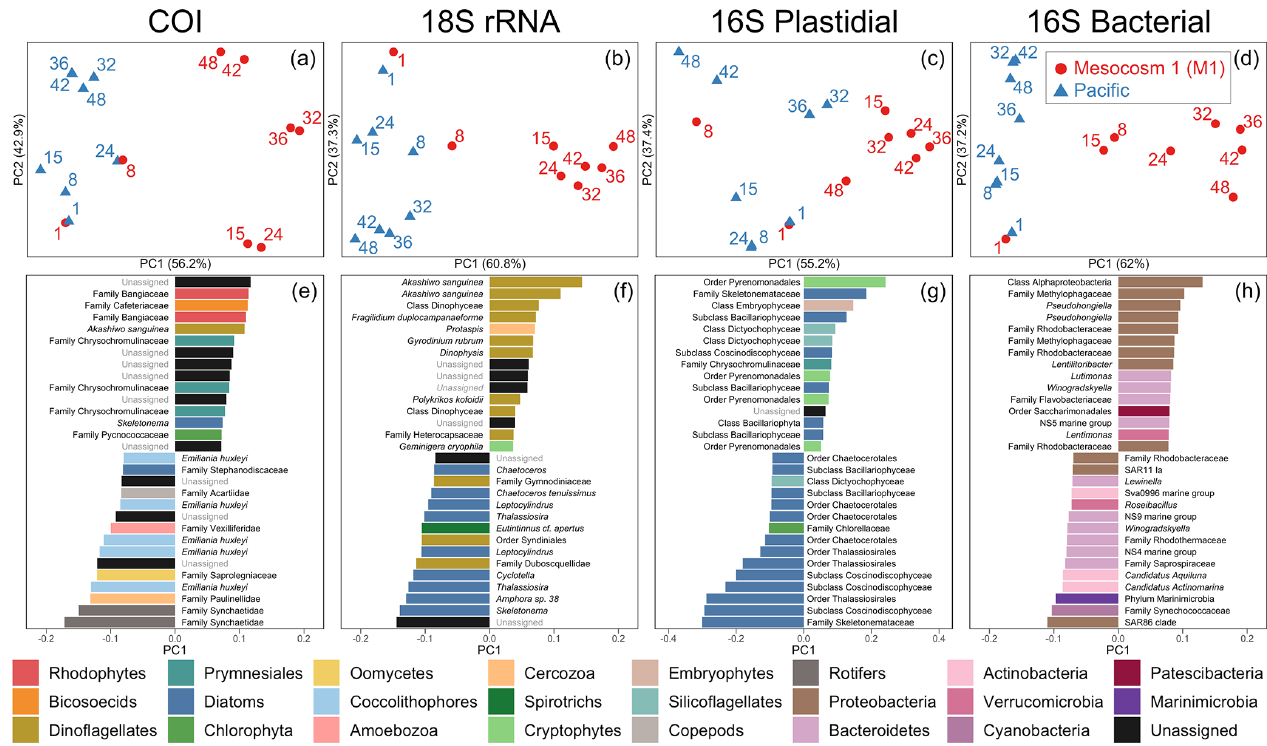
Figure 3. Beta diversity analyses using DEICODE robust Aitchison PCA for (a) COI, (b) 18S rRNA, (c) V1–V2 16S rRNA plastidial ASVs, and (d) V1–V2 16S rRNA bacterial ASVs, including photosynthetic taxa. Data points represent individual samples; the number next to each data point indicates the day collected. ASV loadings on PC1 from the DEICODE robust Aitchison PCA for (e) COI, (f) 18S rRNA, (g) V1– V2 16S rRNA plastidial ASVs, and (h) V1–V2 16S rRNA bacterial ASVs. As seen in (a) , (b) , (c) , and (d) and confirmed by a PERMANOVA test, PC1 separates the Pacific samples and pre-OMZ water addition M1 samples from the post-OMZ water addition M1 samples (days 15 + ), and thus positive loading scores are associated with the mesocosm, whereas negative loading scores are associated with the Pacific samples. The text adjacent to the loading scores represents the lowest taxonomy to which that ASV was annotated. The taxonomy assigned to 16S rRNA ASVs corresponds to that of the SILVA